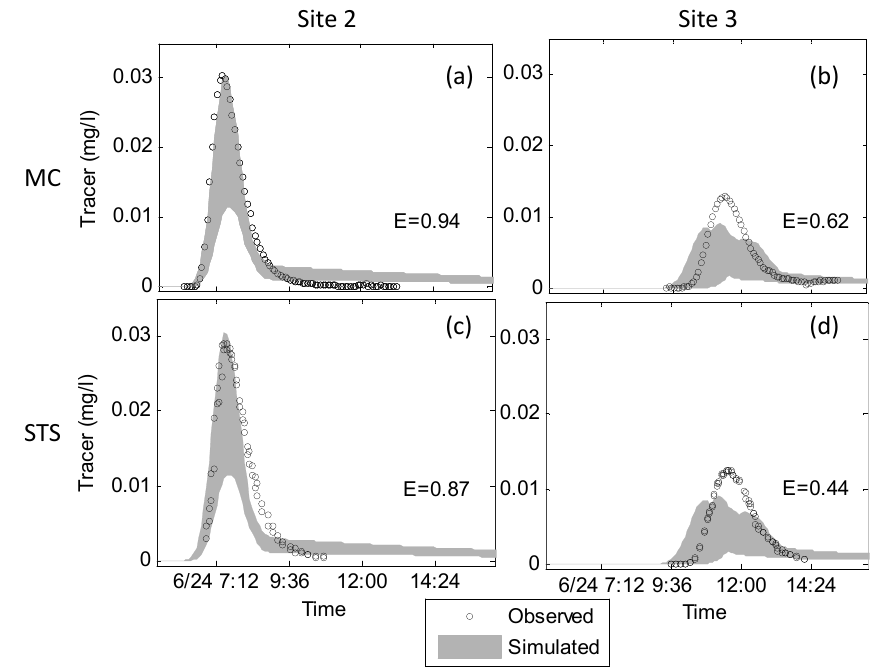
Fig. 6. Test 7 (Level 2) plots of tracer data with results at Site 2 and Site 3 in the main channel (MC) (a, b) , and STS (c, d) . E , the local performance at each location, is shown in each subplot.